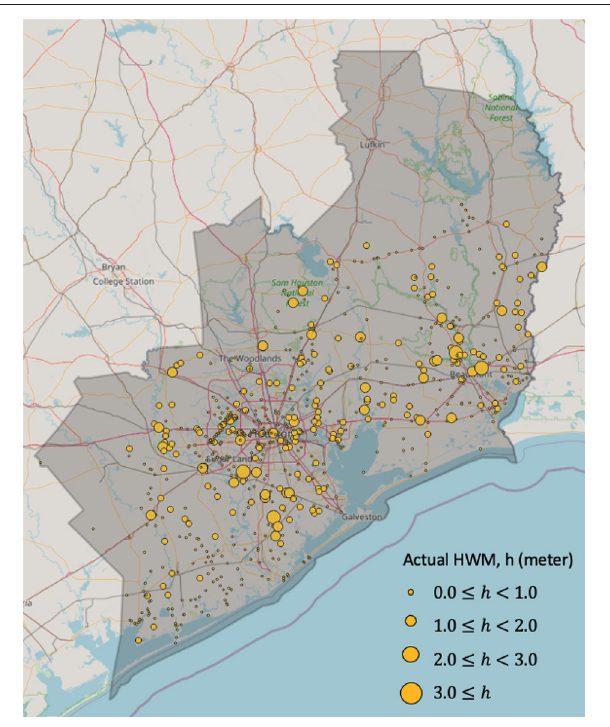
FIGURE 4 | The circles represent the actual HWMs of the 750 sites within the CMOC